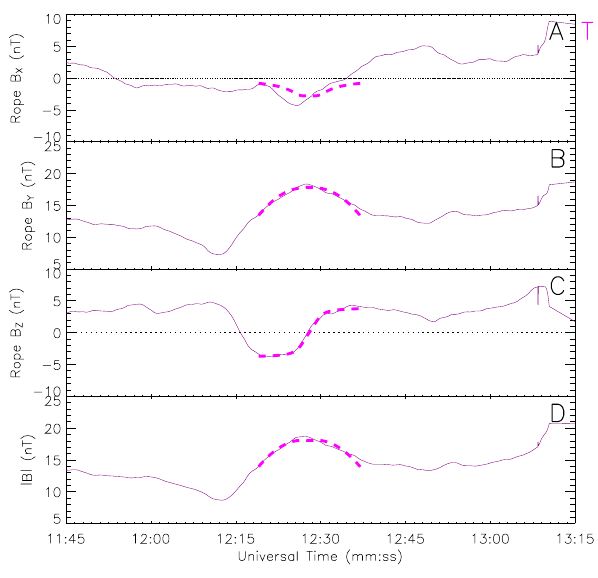
Fig. 5. Model fit for Signature 2. The thick dashed line represents the model flux rope, the thinner solid line the FGM data from TC- 1. Panels (A–C) show the three field components in the flux rope model frame and panel (D) the total field.